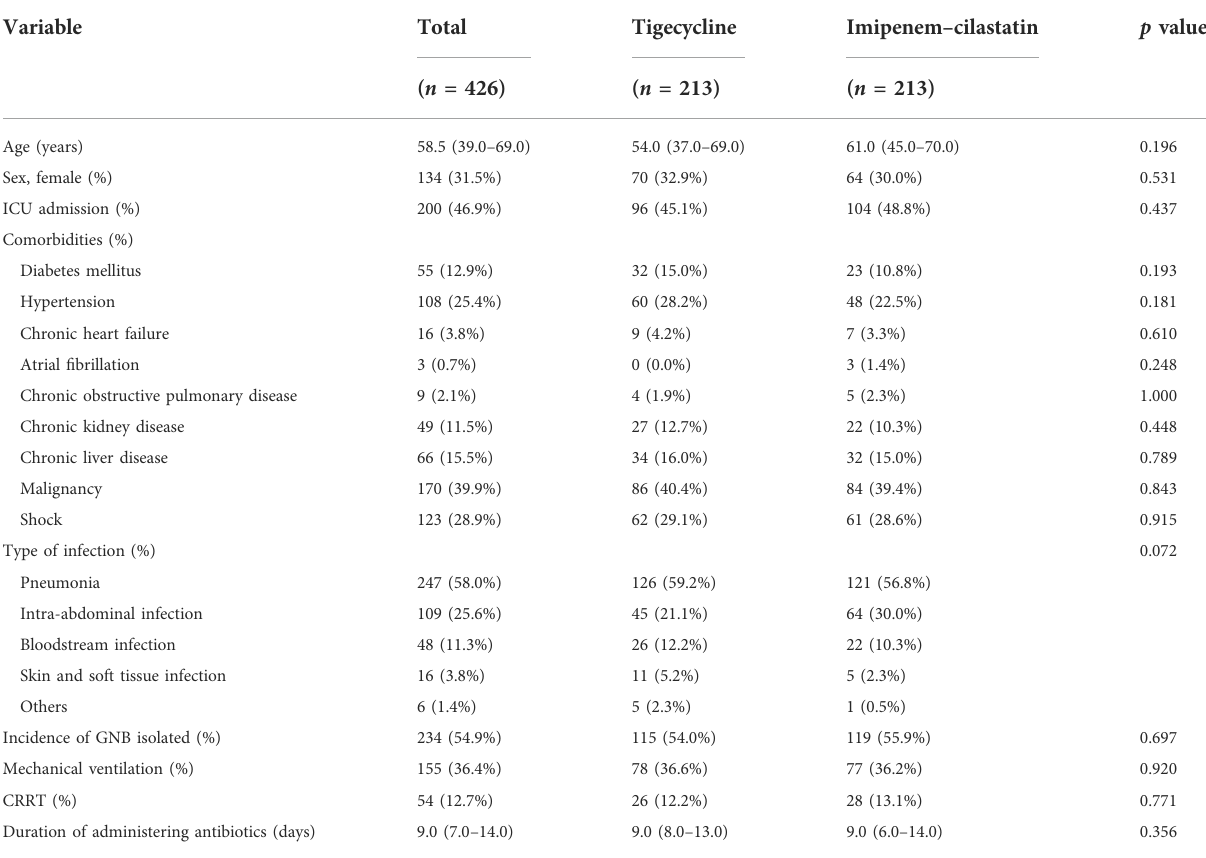
TABLE 3 Patient characteristics after 1:1 propensity score